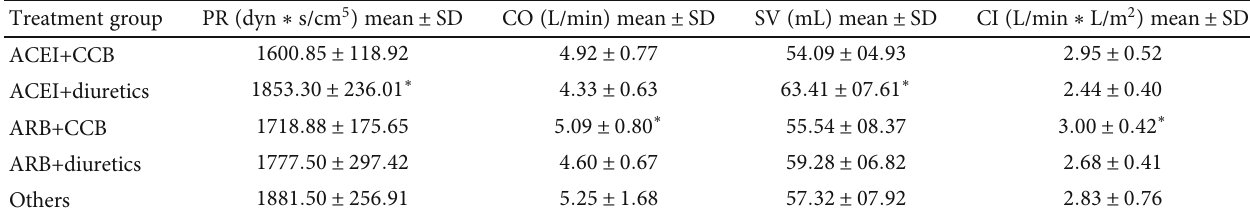
Table 7: Advanced hemodynamic